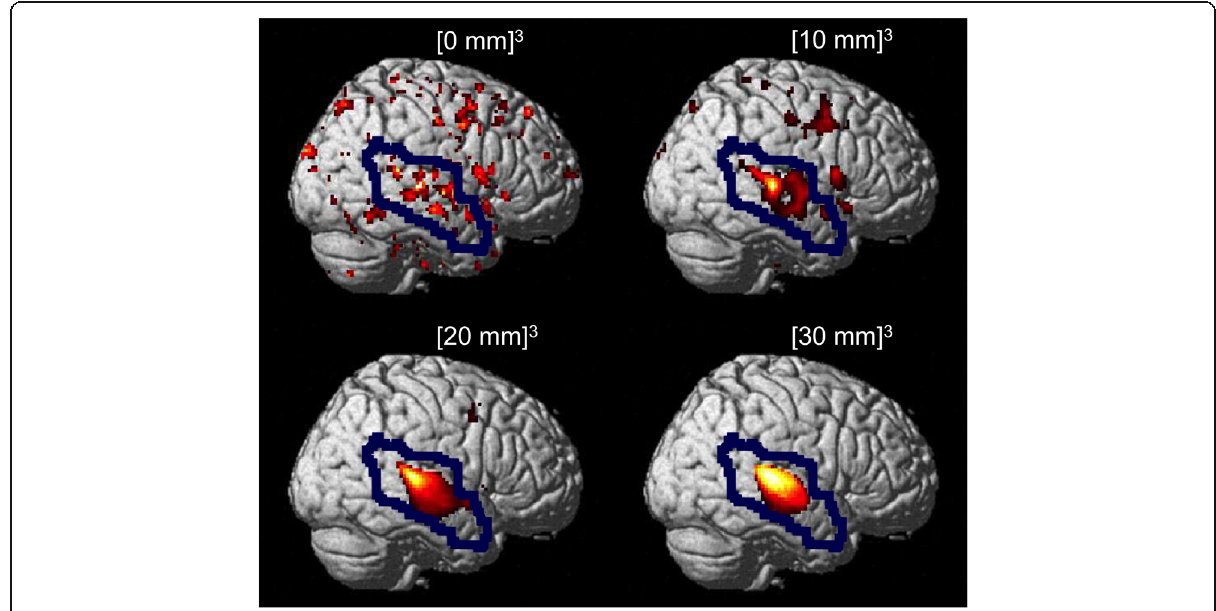
Fig. 2 Examples of activations in auditory and extra-auditory regions (AR and eAR separated by blue line) detected with different smoothing filter kernels (always using a cut-off for statistical inferences of p <0.01). Stimulation was done in an adult patient via promontory needle electrode during awake state. Note: The highest proportion of activation in the auditory cortex was detected with the second highest degree of smoothing (filter kernel of approximately three times of the full width at half maximum, [20 mm] 3 ). Higher degrees of smoothing result in the detection of less extra-auditory